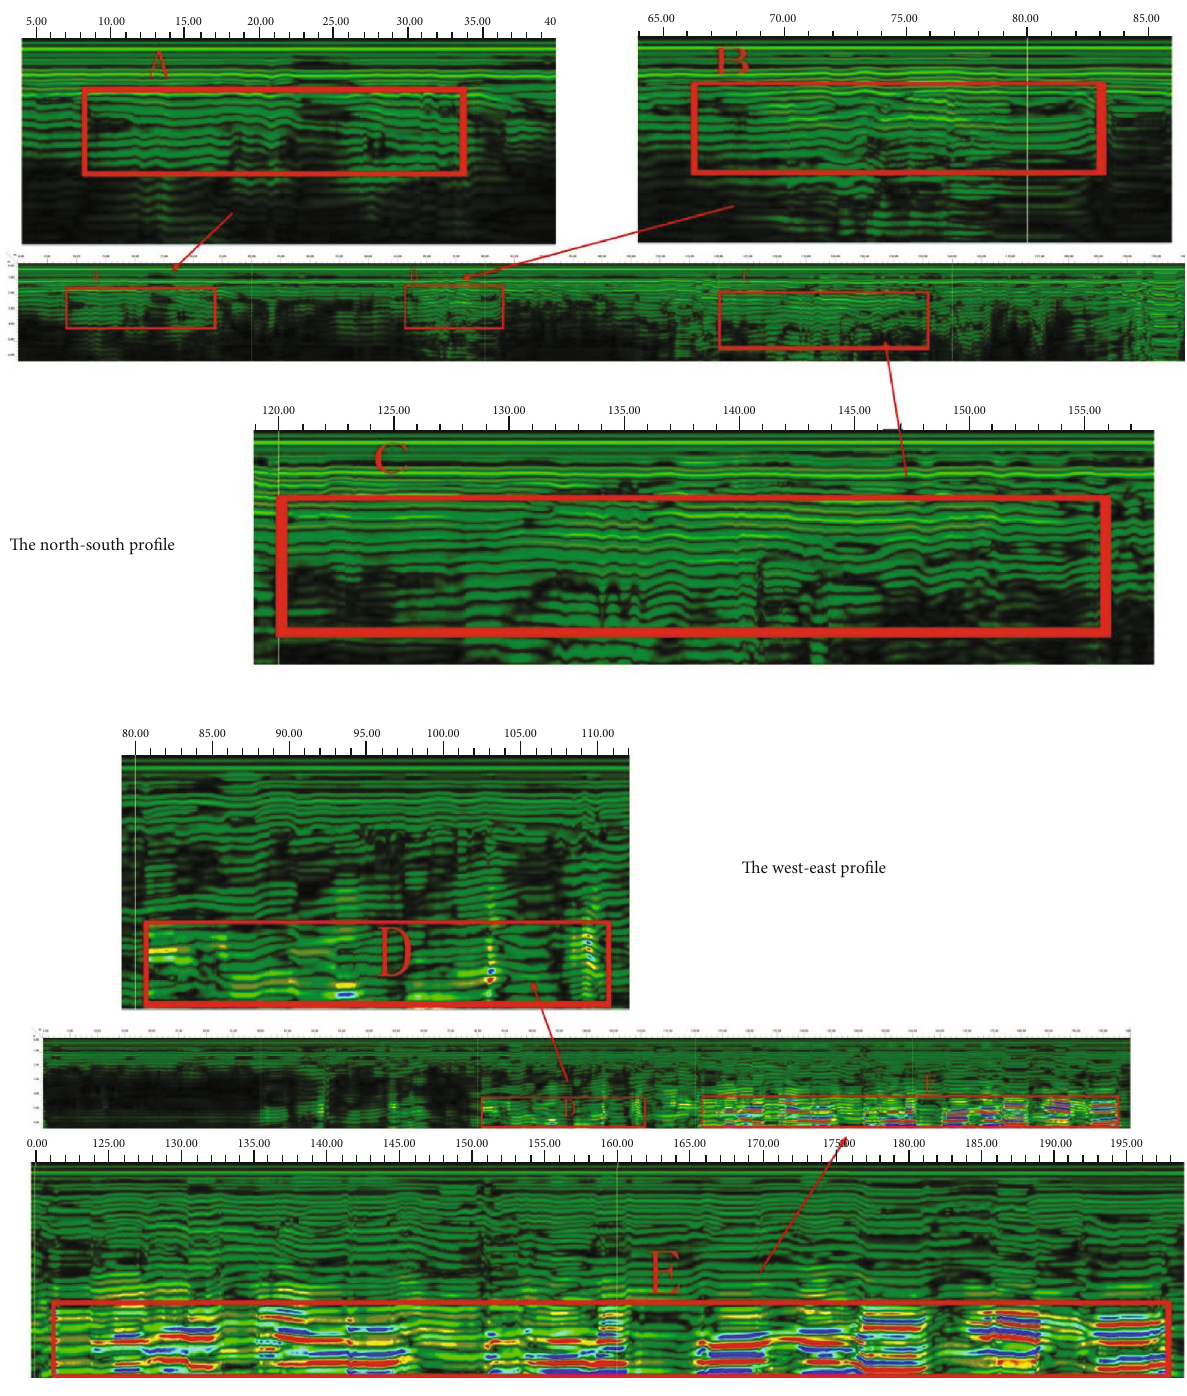
Figure 18: Ground penetrating radar results. The three abnormal areas A, B, and C in the west-east direction basically correspond to the three low-resistance abnormal areas near the surface of the autumn survey results, and the abnormal re fl ection points of D and E in the north-south direction basically correspond to the two low-resistance abnormal areas near the surface of the resistivity pro fi